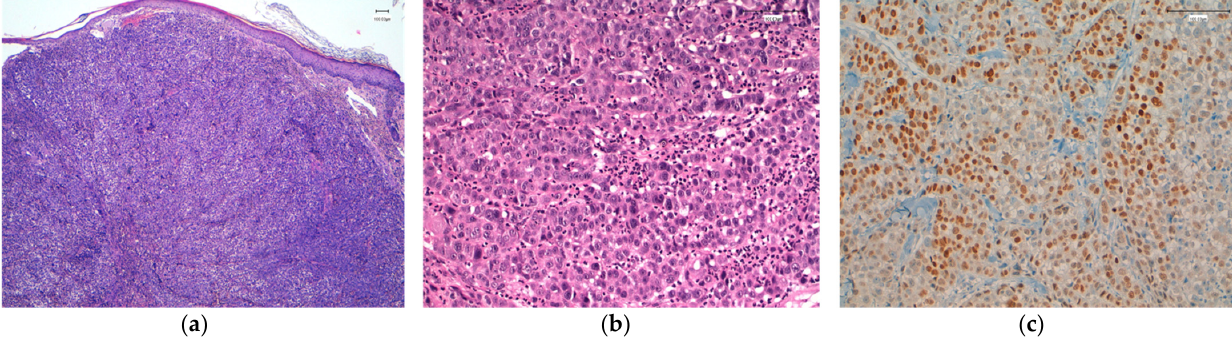
Figure 5. ( a ) Solid pattern of infiltration in a cutaneous nodular metastasis from a triple-negative breast carcinoma of no special type. Original magnification, 40 ×. ( b ) Tumor cells forming solid nests in the dermis. Original magnification, 200×. ( c ) Intense expression of SOX10 (Clon SP267, Roche). Original magnification, 200×.